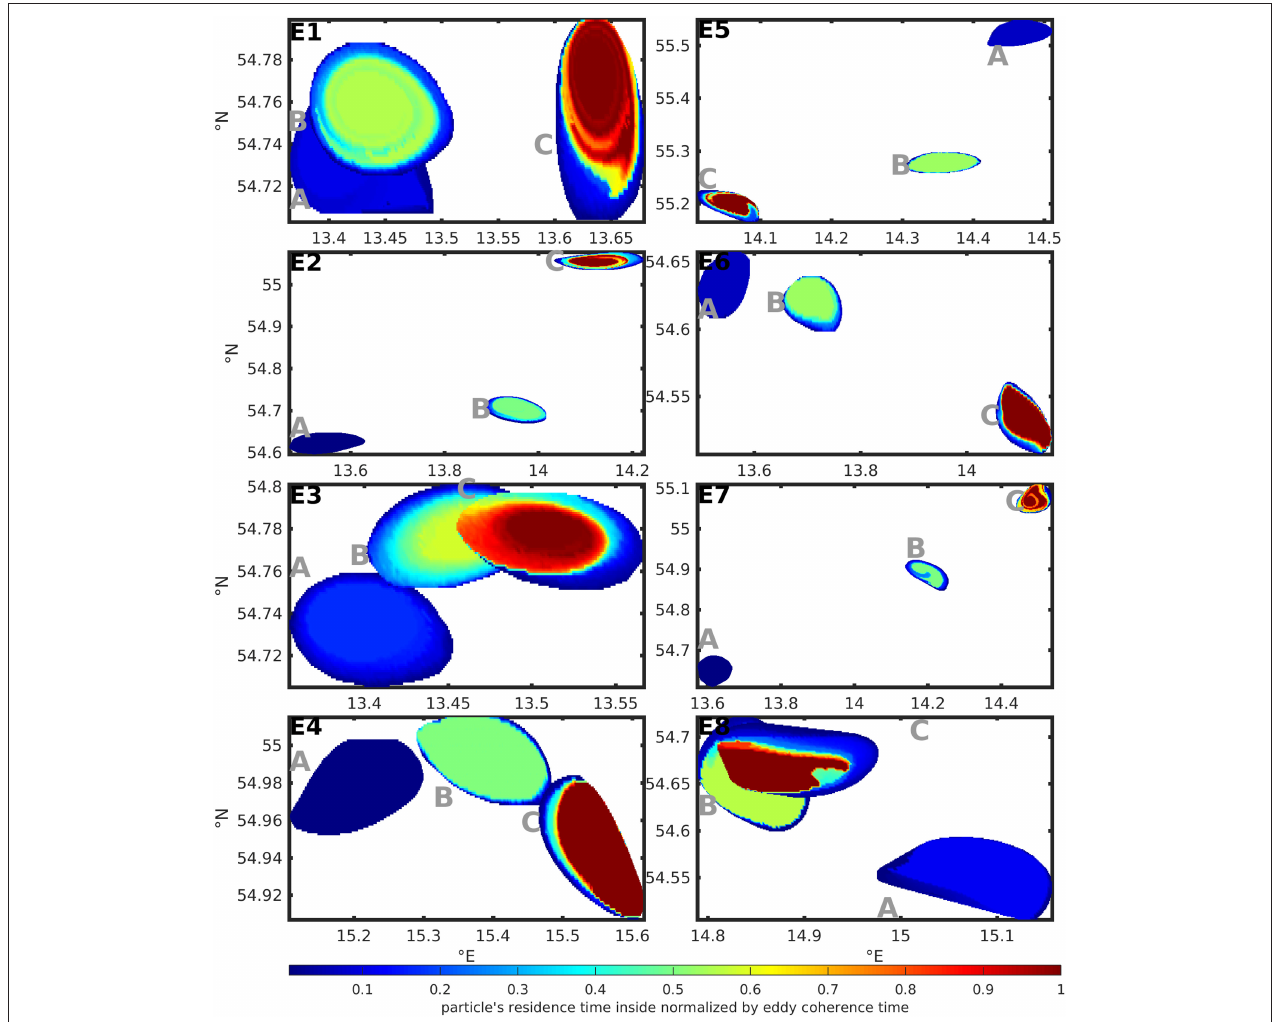
FIGURE 5 | Color-coded residence time of tracers in relation to the eddy coherence time inside the selected test case eddy shapes at (A) the first detection of the coherent eddy, (B) half of the coherence time of the eddy and (C) the last detection of the coherent eddy. The shapes are based on TOA and the residence times on